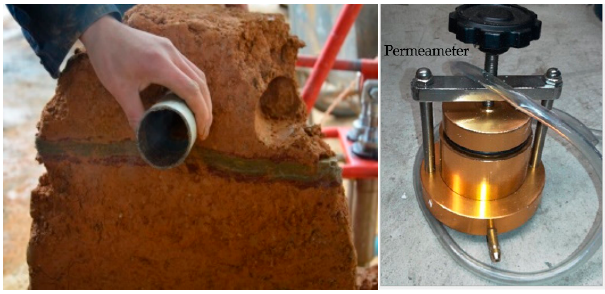
Figure 16. Specimen sampling and permeability test.